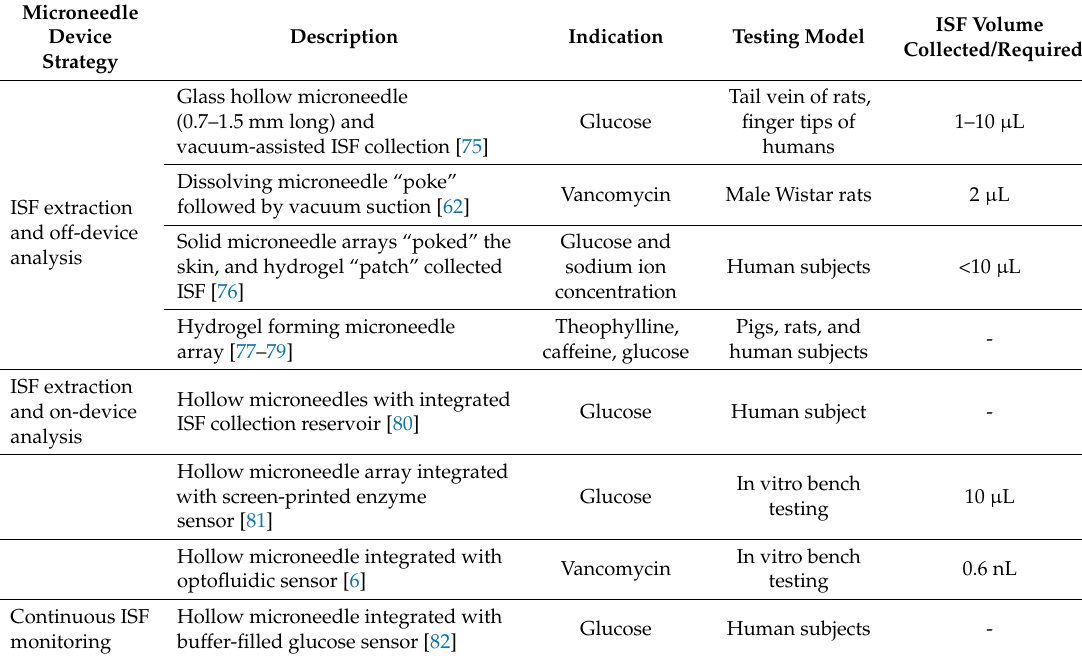
Table 1. Summary of microneedle strategies used for interstitial fluid (ISF) collection and therapeutic drug